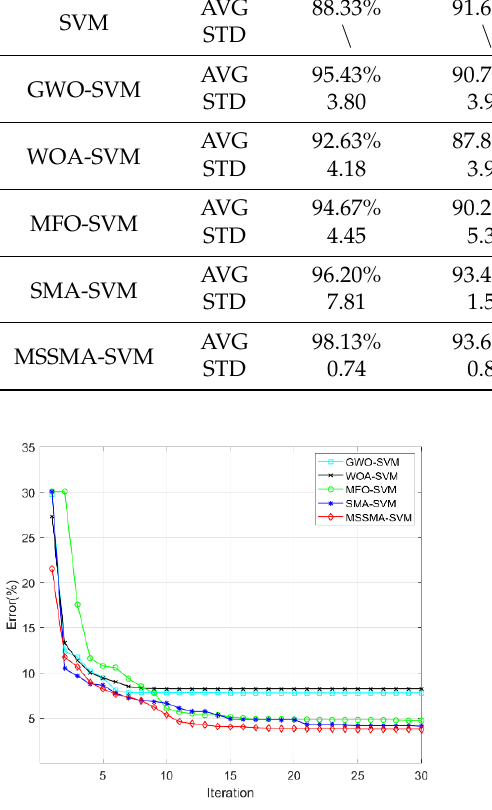
Figure 8. Error curves of different models.